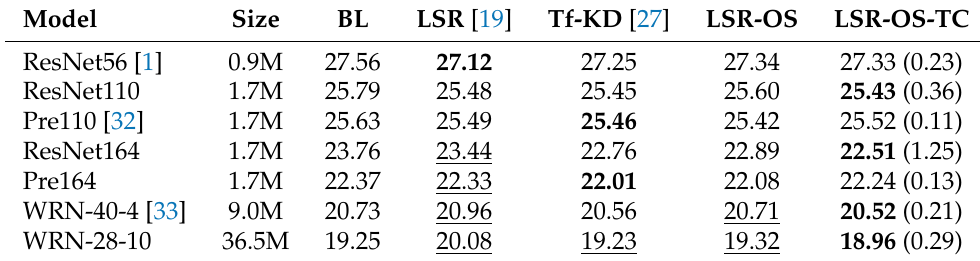
Table 1. Test set error rate comparison on the CIFAR-100 dataset. The “BL” in the table’s column head is short for “baseline”. The results with no improvement compared to the baselines are underlined, and the bold results are the best ones for every network. The relative error rate drop of LSR-OS-TC compared to the baseline is shown in the